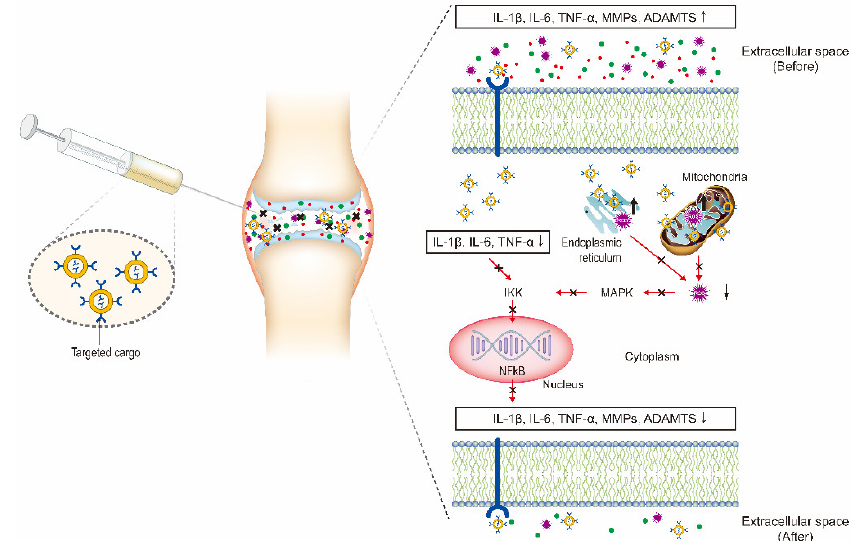
Figure 3. Intra-articular (IA) delivery of cargo-loaded nanoparticles for the treatment of OA. The therapeutic effects are obtained by the NPs targeting the three major factors including inflammatory factors, proteolytic enzymes, and reactive oxygen species (ROS) to inhibit NF-κB signaling pathway.